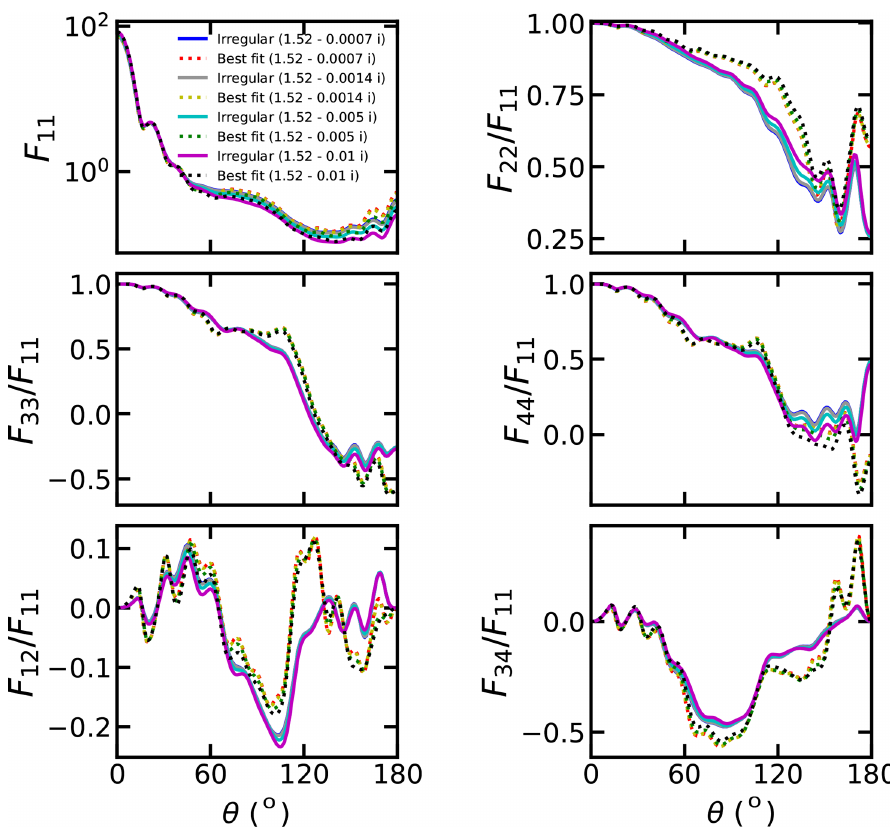
Figure 8. Similar to Fig. 4 but for different refractive indices, where f = 0 .